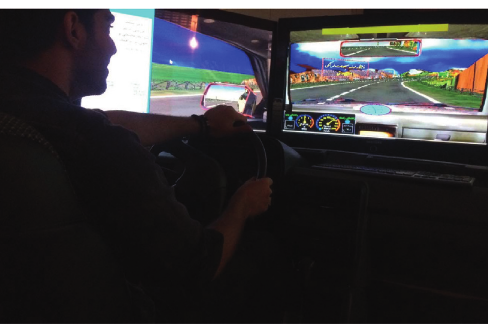
Figure 3: Driving simulator cabin. Table 3: Images related to the simulated environment for each